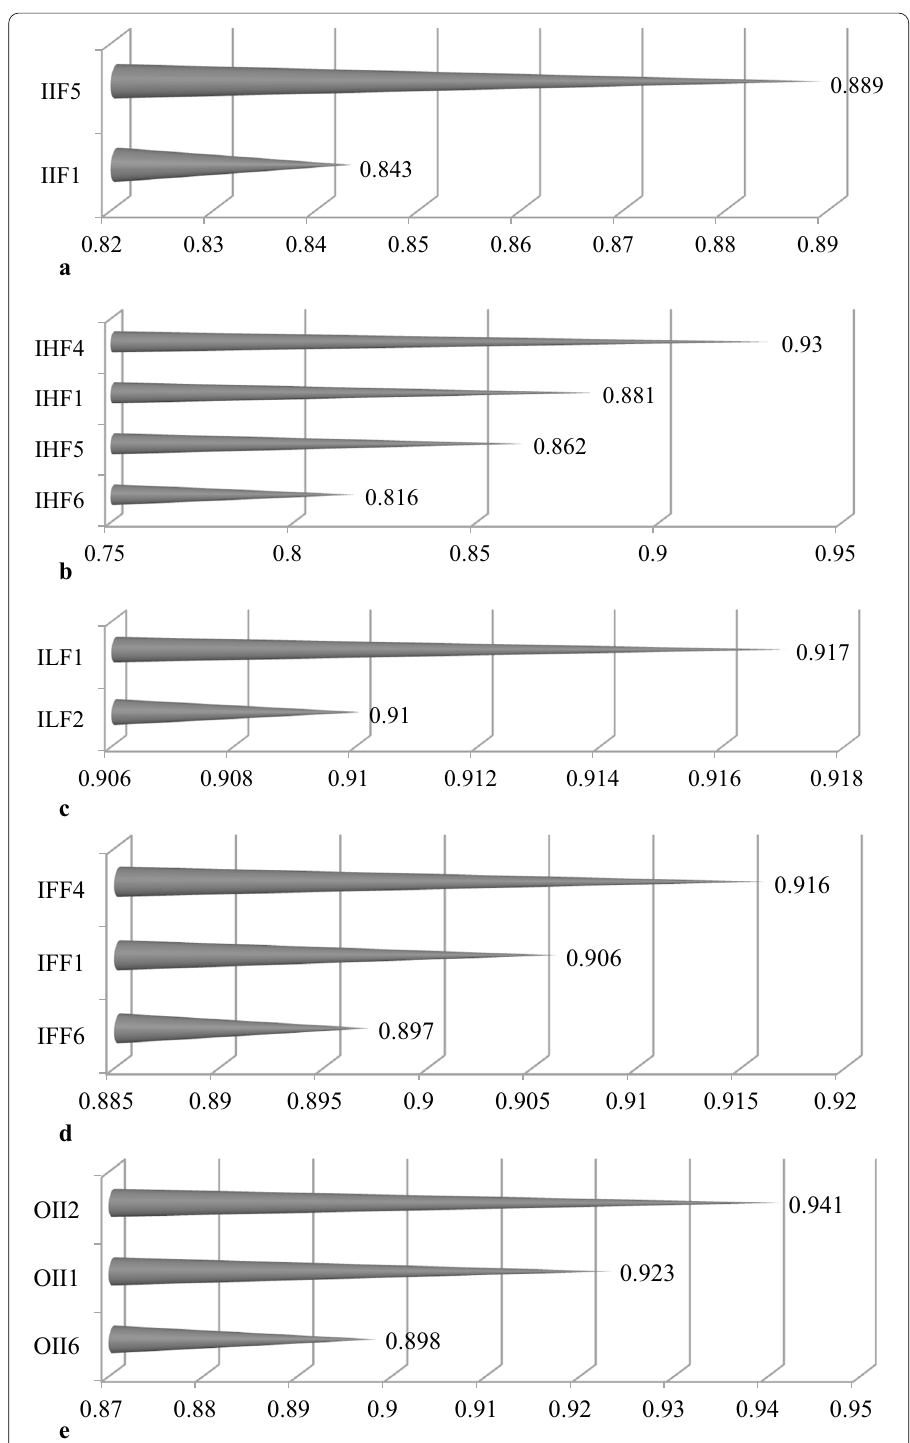
Fig. 3 a Estimations of factor loadings of IIF latent variable. b Estimations of factor loadings of IHF latent variable. c Estimations of factor loadings of ILF latent variable. d Estimations of factor loadings of IFF latent variable. d Estimations of factor loadings of IFF latent variable. e Estimations of factor loadings of OII latent